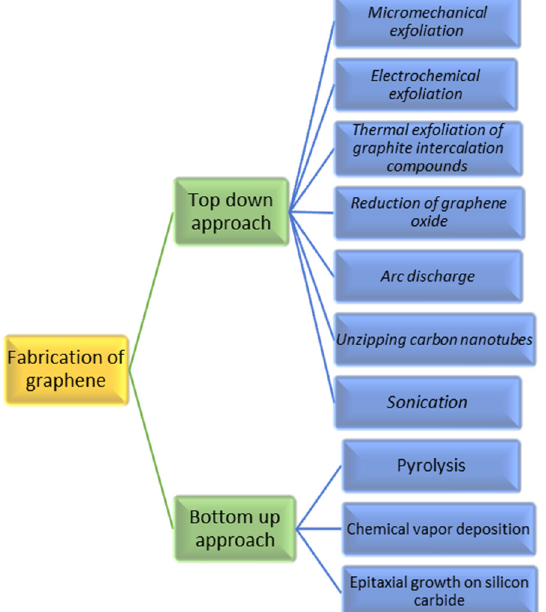
Figure 9. Detailed flowchart of various graphene synthesis techniques in top down and bottom-up approaches. “Reproduced with permission from [101], [TrAC Trends in Analytical Chemistry]; published by [Elsevier], [2019]”.